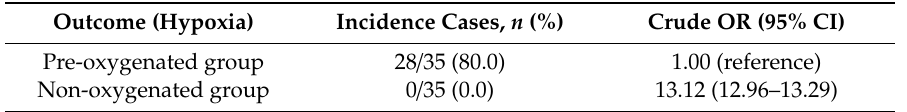
Table 3. Relative risk (95% CI) of hypoxia by group using bootstrapping in logistic regression